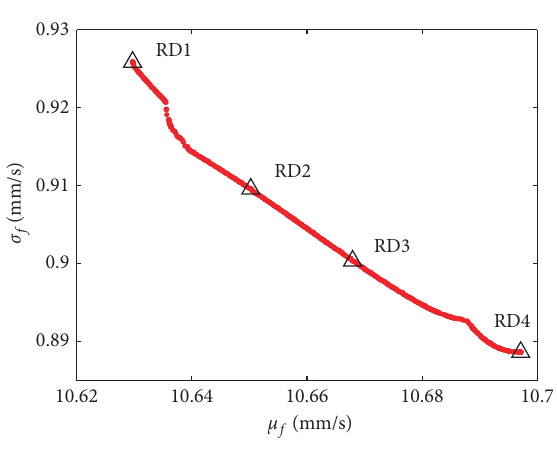
Figure 17: The Pareto set. Table 4: The results obtained by the proposed method and Monte Carlo